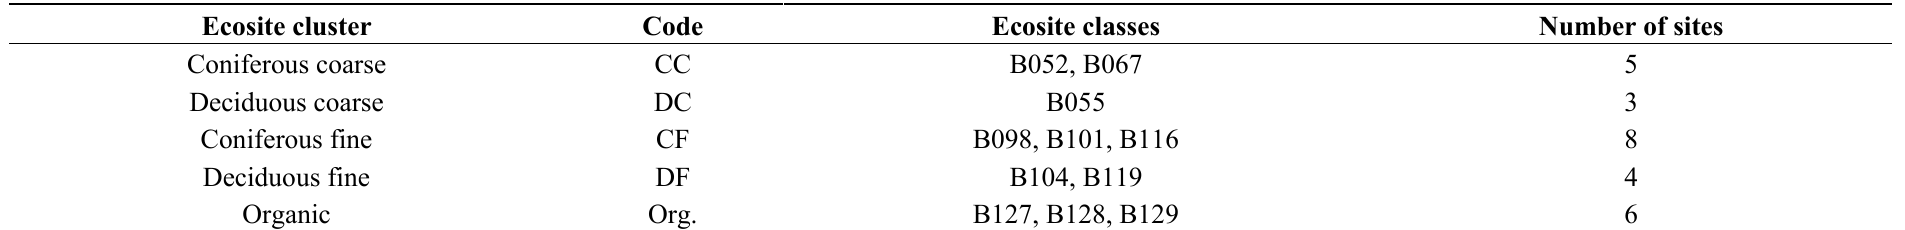
Table 3. Ecosite cluster